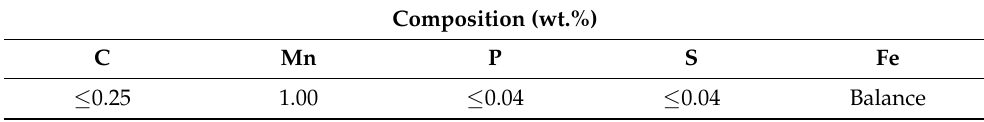
Figure 1. Schematic illustration of the sectioning procedures used to prepare the specimen from the DH pipeline weldment. DH pipeline weldment. Table 1. Composition of the DH pipeline materials (SPW400). Table 1. Composition of the DH pipeline materials (SPW400).